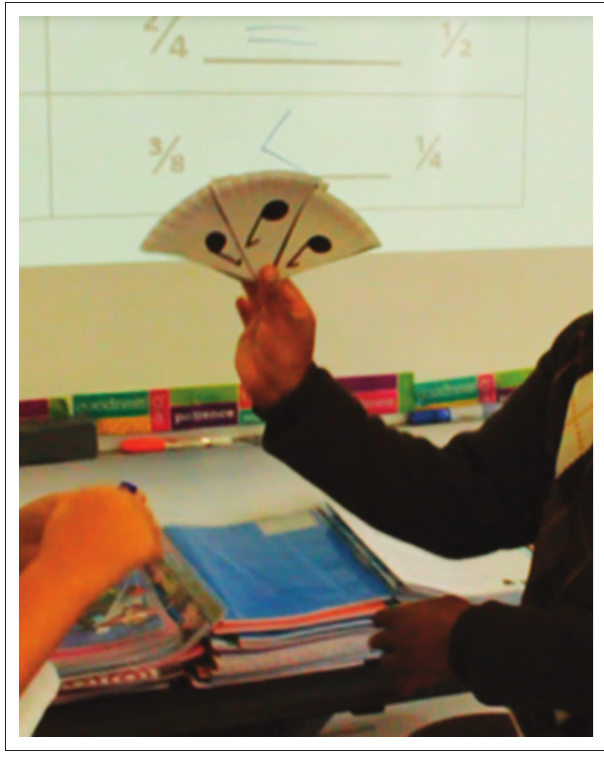
Source : Lovemore, T.S., 2020, `Enriching my teaching around the inverse order relationship in unit fractions at the grade 5 level through the inclusion of musical activities: An action research case study’, unpublished Master of Education thesis, Faculty of Education, Rhodes FIGURE 5: Two learners demonstrating with paper plate learning support materials that three-eighth notes are longer than one-quarter note; therefore, 3 1 8 is more than 4